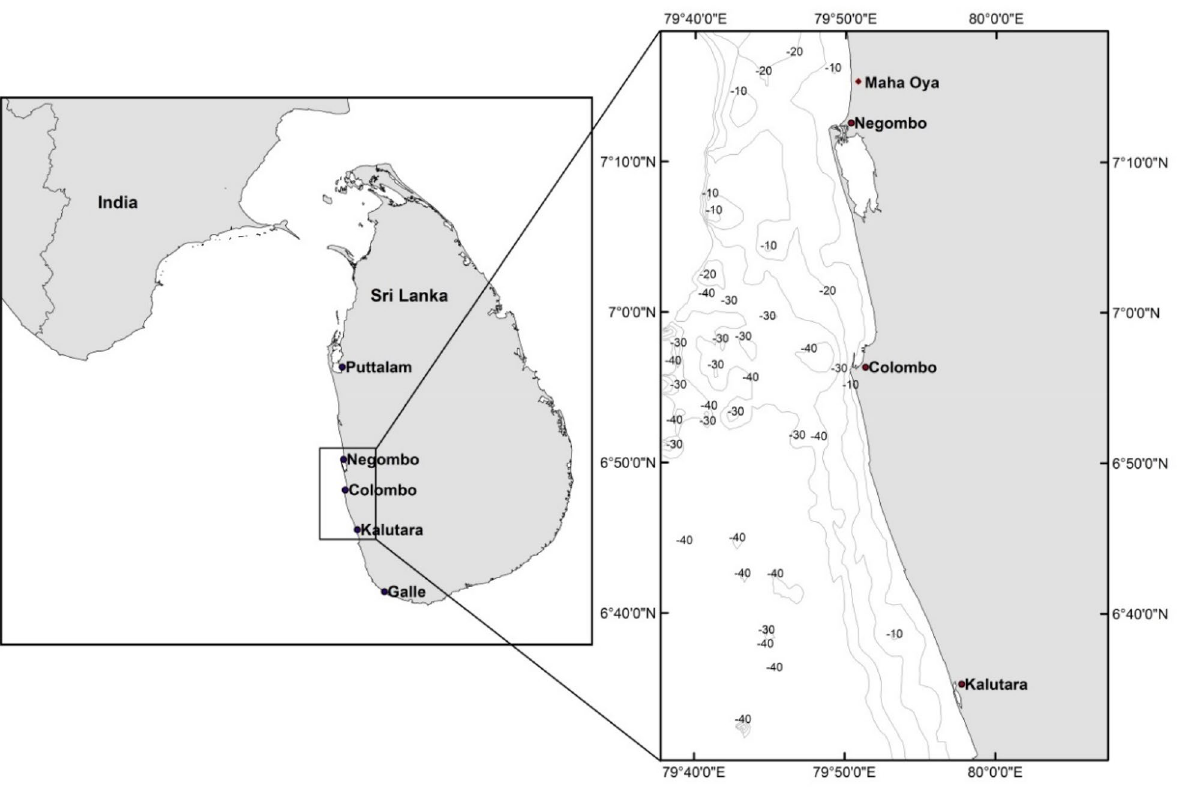
Figure 2. Location of Sri Lanka (left) and the 3 case study sites (right). The locations of the Capital city Colombo and other towns mentioned herein are also shown (Reproduced from Duong et al. 24 , all rights reserved).